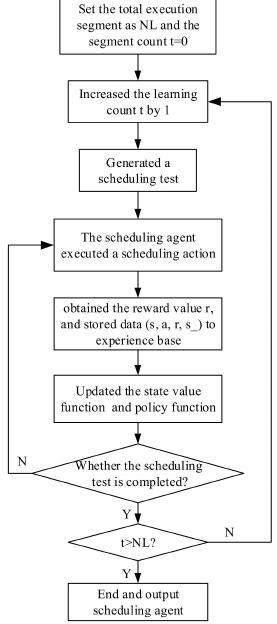
Figure 7. The training procedure of scheduling